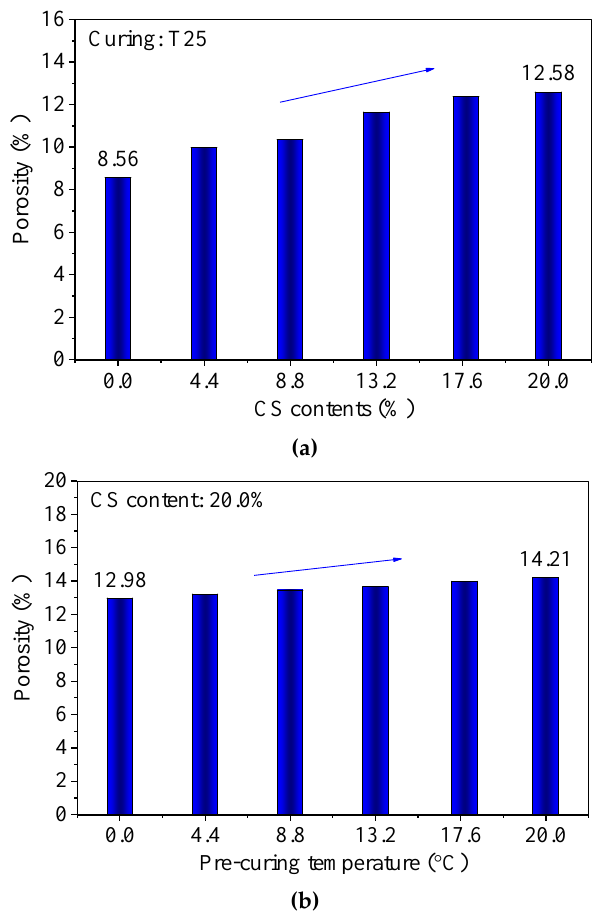
Figure 7. The porosities of CS − FA − GEO samples at 60 d: ( a ) with different CS contents, and ( b ) under different pre-curing temperatures.